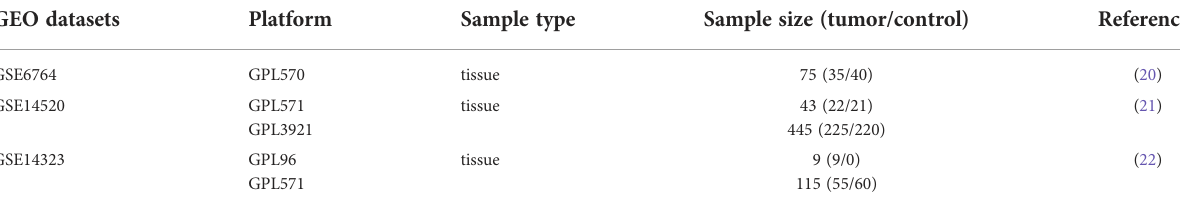
TABLE 1 Detailed characteristics of the three GEO datasets in our